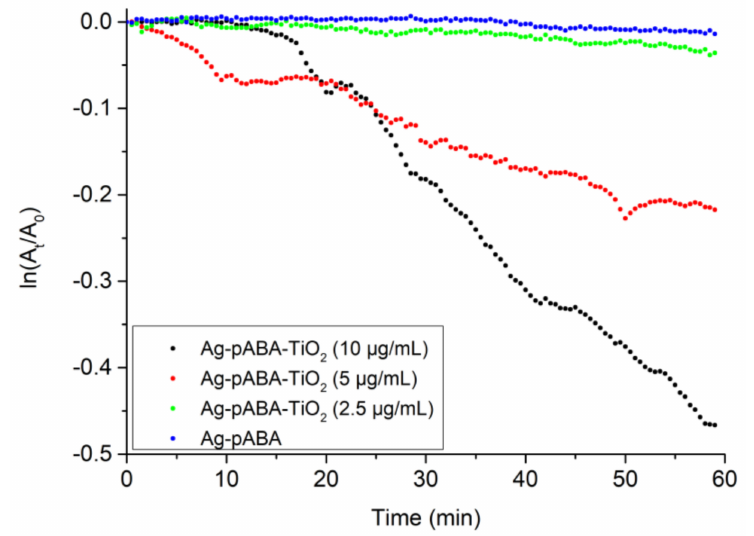
Figure 9. The disappearance rate of 4-NP in Ag-pABA-TiO 2 with di ff erent concentrations of Ag-pABA (Ag-pABA amounts under parenthesis). For comparison purposes, the activity of Ag-pABA at similar concentration as the lowest (2.5 µ g / mL) amount of catalyst is also